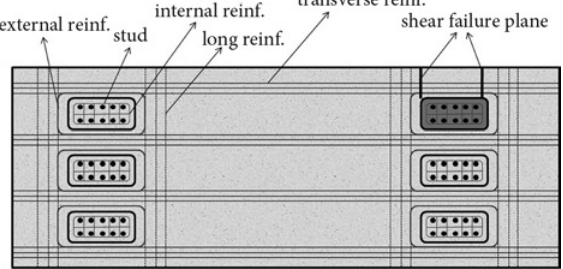
Fig. 11. Detail recommendation for shear connection in